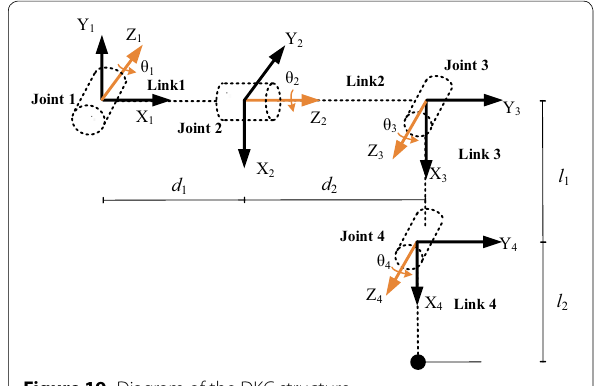
Figure 19 Diagram of the DKC structure